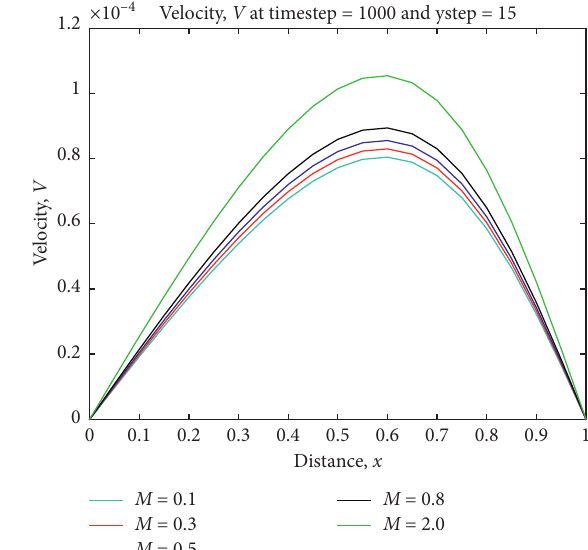
Figure 2: Graph of effects of Hall parameters on secondary velocity profile v .